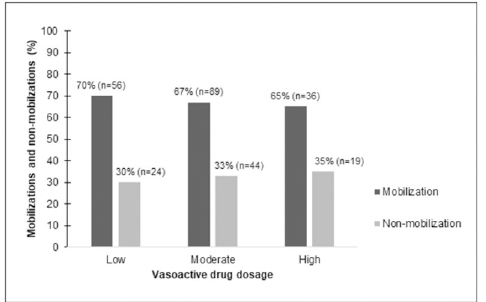
Fig 2. Vasoactive drugs dosage versus mobilization and non-mobilization